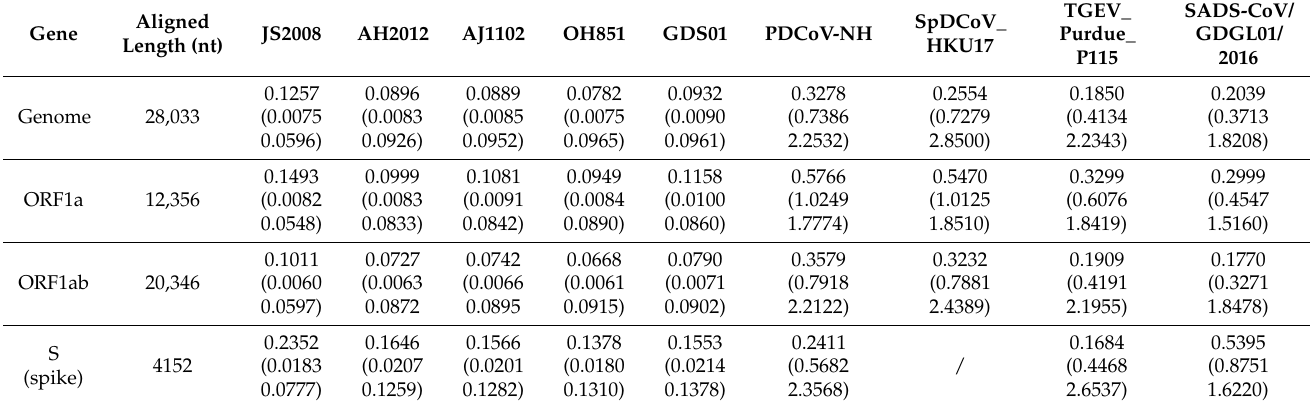
Table 1. The molecular divergence between PEDV and related